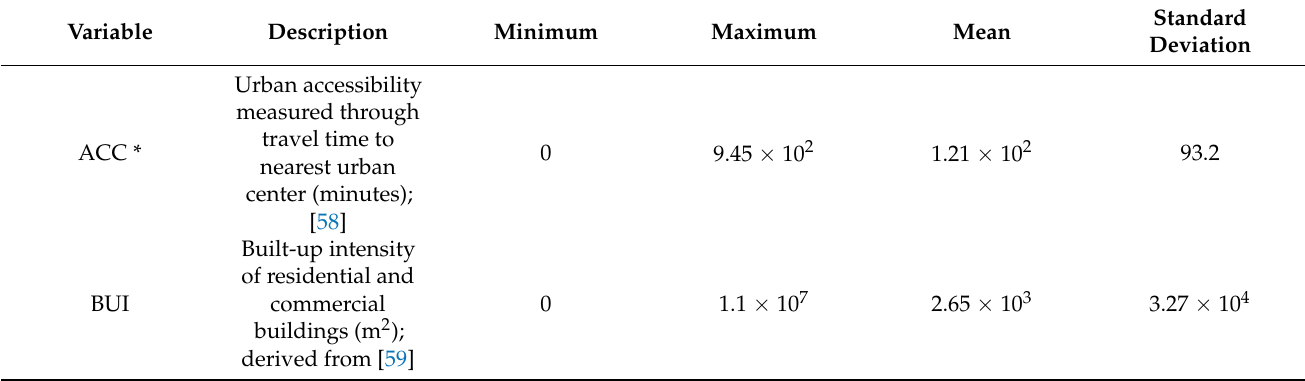
Table 2. The candidate set of geospatial variables used to model capacity density. Descriptive statistics are provided for the conterminous United States